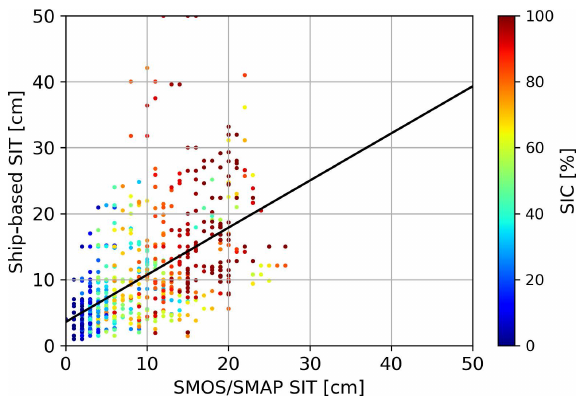
Figure 11. Comparison of ASPeCT-based ice thicknesses observa- tions by R/V Sikuliaq and the SMOS–SMAP retrieval. Ice concen- tration from the ASI product for the corresponding ice thickness observation is color coded. The black line represents the linear re- gression of the two